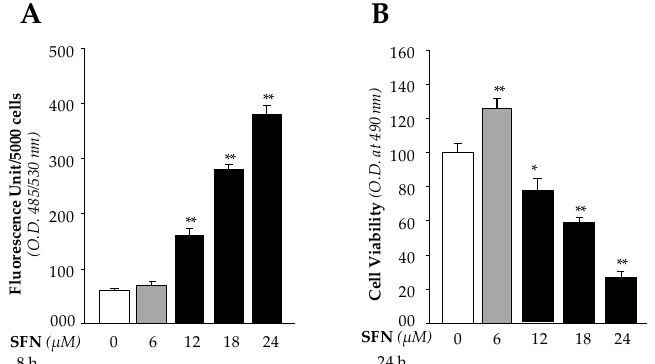
Figure 1. Lethal doses of SFN increased accumulation of ROS and reduced cell viability. Cultured hLECs were treated with increasing amounts of SFN as indicated. ( A ) After 8 h, ROS were quantified by H2-DCF-DA dye as described in “Materials and Methods” section. ( B ) MTS assay was conducted to monitor cell viability against oxidative stress after 24 h. The data represent the mean ± S.D. from three independent experiments. * p < 0.05, ** p < 0.001; SFN treated versus untreated (DMSO)